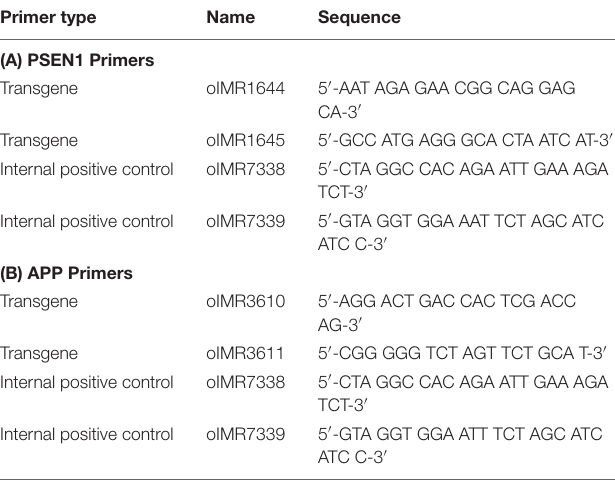
TABLE 1 | PCR primers for genotyping wild-type and mutant embryos.